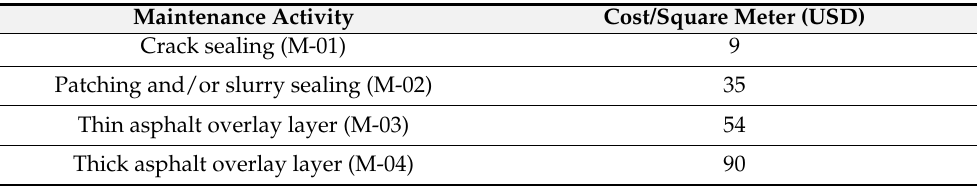
Table 3. Estimated unit cost for maintenance activities (prices were set in